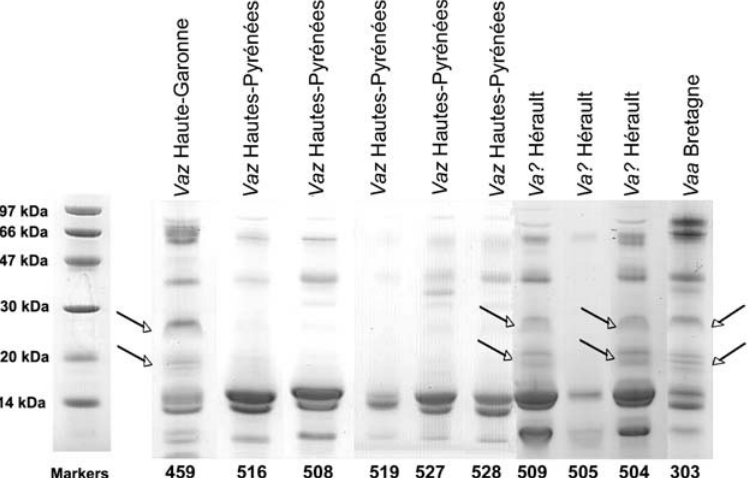
Figure 15. Hybrid SDS-PAGE venom profiles from snakes captured in He´rault (code no. 34) and Haute-Garonne (code no. 31). Venoms 504, 505, and 509 from He´rault, 459 from Haute-Garonne, Vaz -type venoms 508, 516, 519, 527, 528 from Hautes-Pyre´ne´es and Vaa -type venom 303 from Loire- Atlantique were separated by a 20% SDS-PAGE under denaturating and reducing condtitions. Molecular weight markers are shown on the left. Arrows indicate protein bands specifically found in Vaa venoms.